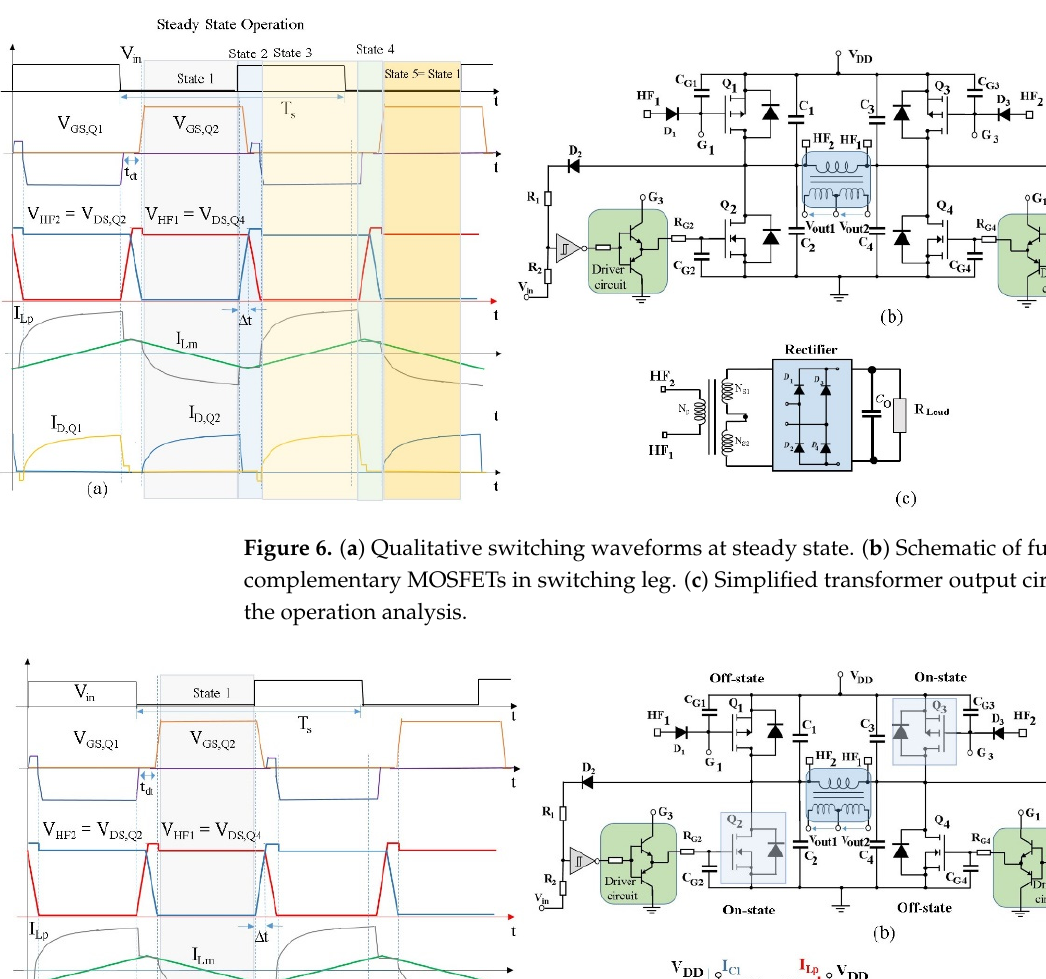
Figure 7. ( a ) Qualitative switching waveforms at starting of the description (State 1). ( b ) Switching conditions of the MOSFETs. ( c ) Primary side of the HF transformer and capacitors’ interactions.